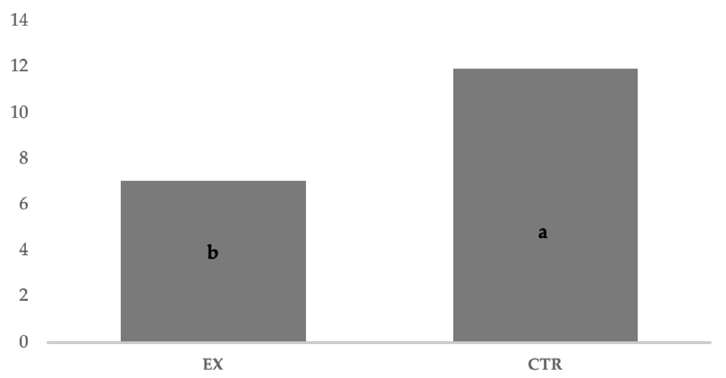
Animals 2021 , 11 , x 8 of 13 Figure 5. Crown-rump length during gestation in function of diets and size. EX: experimental group CTR: control group; a, b: p < 0.05. All dogs showed pregnancy duration (63 ± 2.0 days) that falls in average values